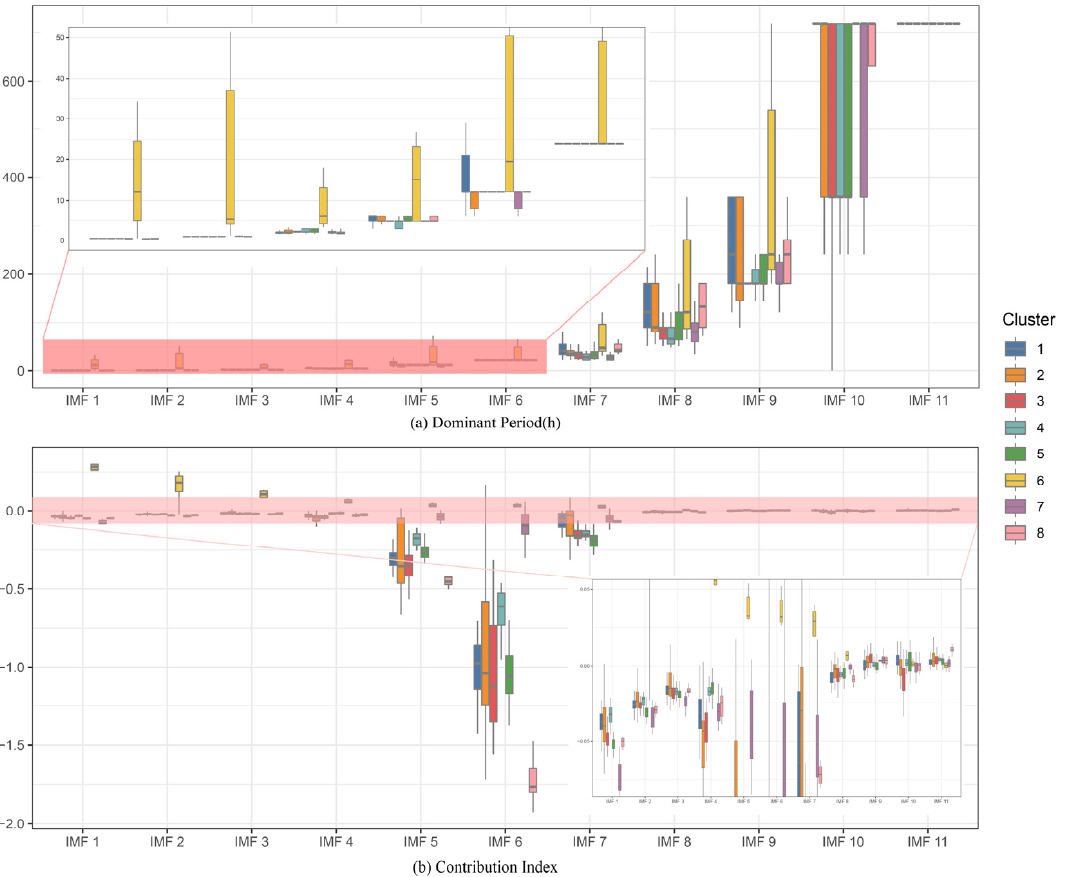
Figure 9. Boxplots of the dominant period and contribution index of each IMF component of each cluster in the spatial partitioning results. ( a ) Dominant period of each IMF component. ( b ) Contribution index of each IMF component of each cluster.